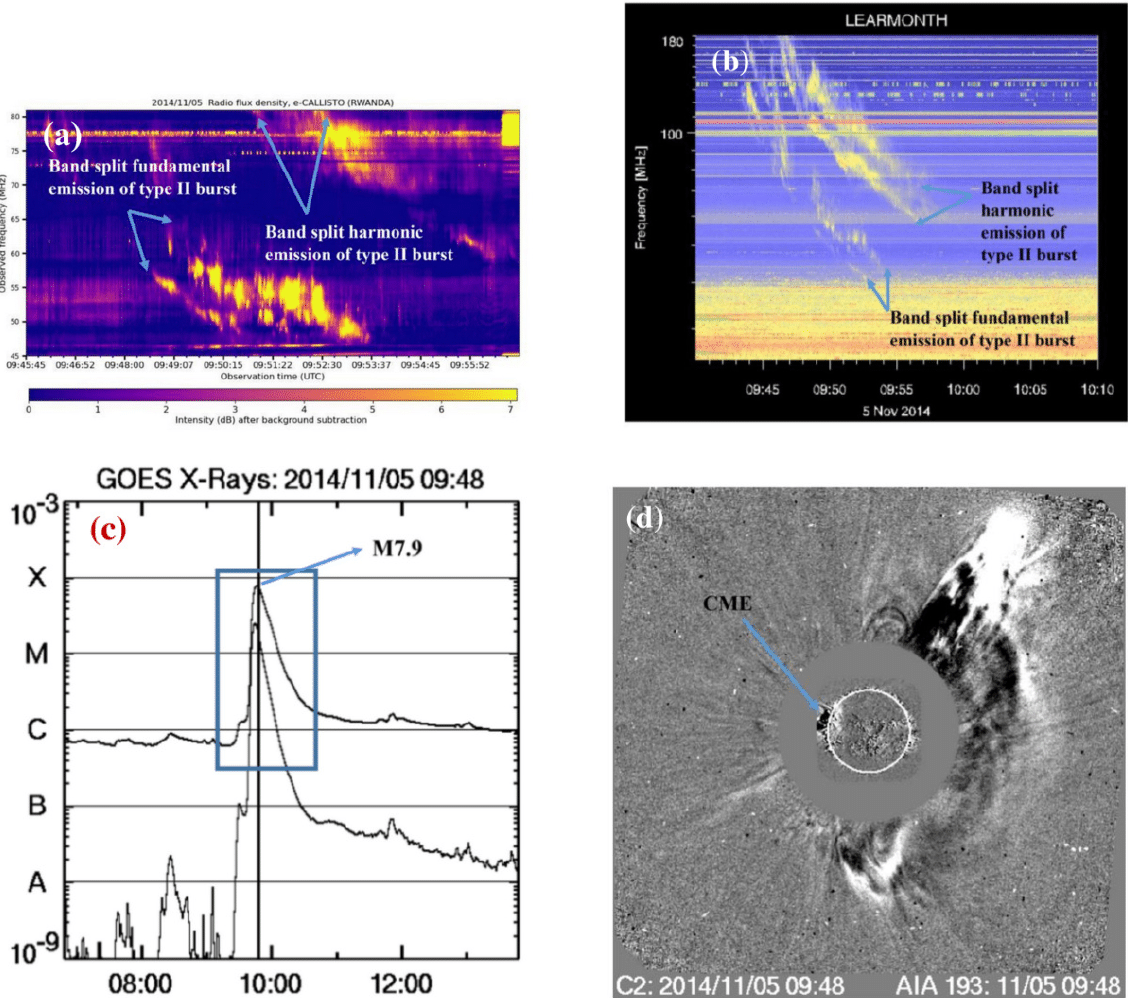
Figure 3. (a) The dynamic spectrum of the 5 November 2014 type II radio burst detected by the CALLISTO station in RWANDA. (b) The 5 November 2014 type II burst observed by the Learmonth Observatory. The event has a fundamental–harmonic (F-H) structure, each with a band split due to the magnetic field. The fundamental band started at 09:48:43UT, with 80.0MHz, and ended at 09:53:32UT, with 47.0MHz, while the harmonic band started at 09:51:00UT, with 80.9MHz, and ended at 09:56:12UT, with 59.0MHz, which corresponds to the drift rates of 0.11 and 0.07MHzs − 1 , respectively. (c) A M7.9 X-ray flare associated with the 5 November 2014 type II burst as detected by GOES satellite. Its start and end times are 09:26 and 09:55UT, respectively. (d) LASCO C 2 difference image shown by blue arrow. The starting time of type II burst, the flare onset and the CME are close, as shown in the